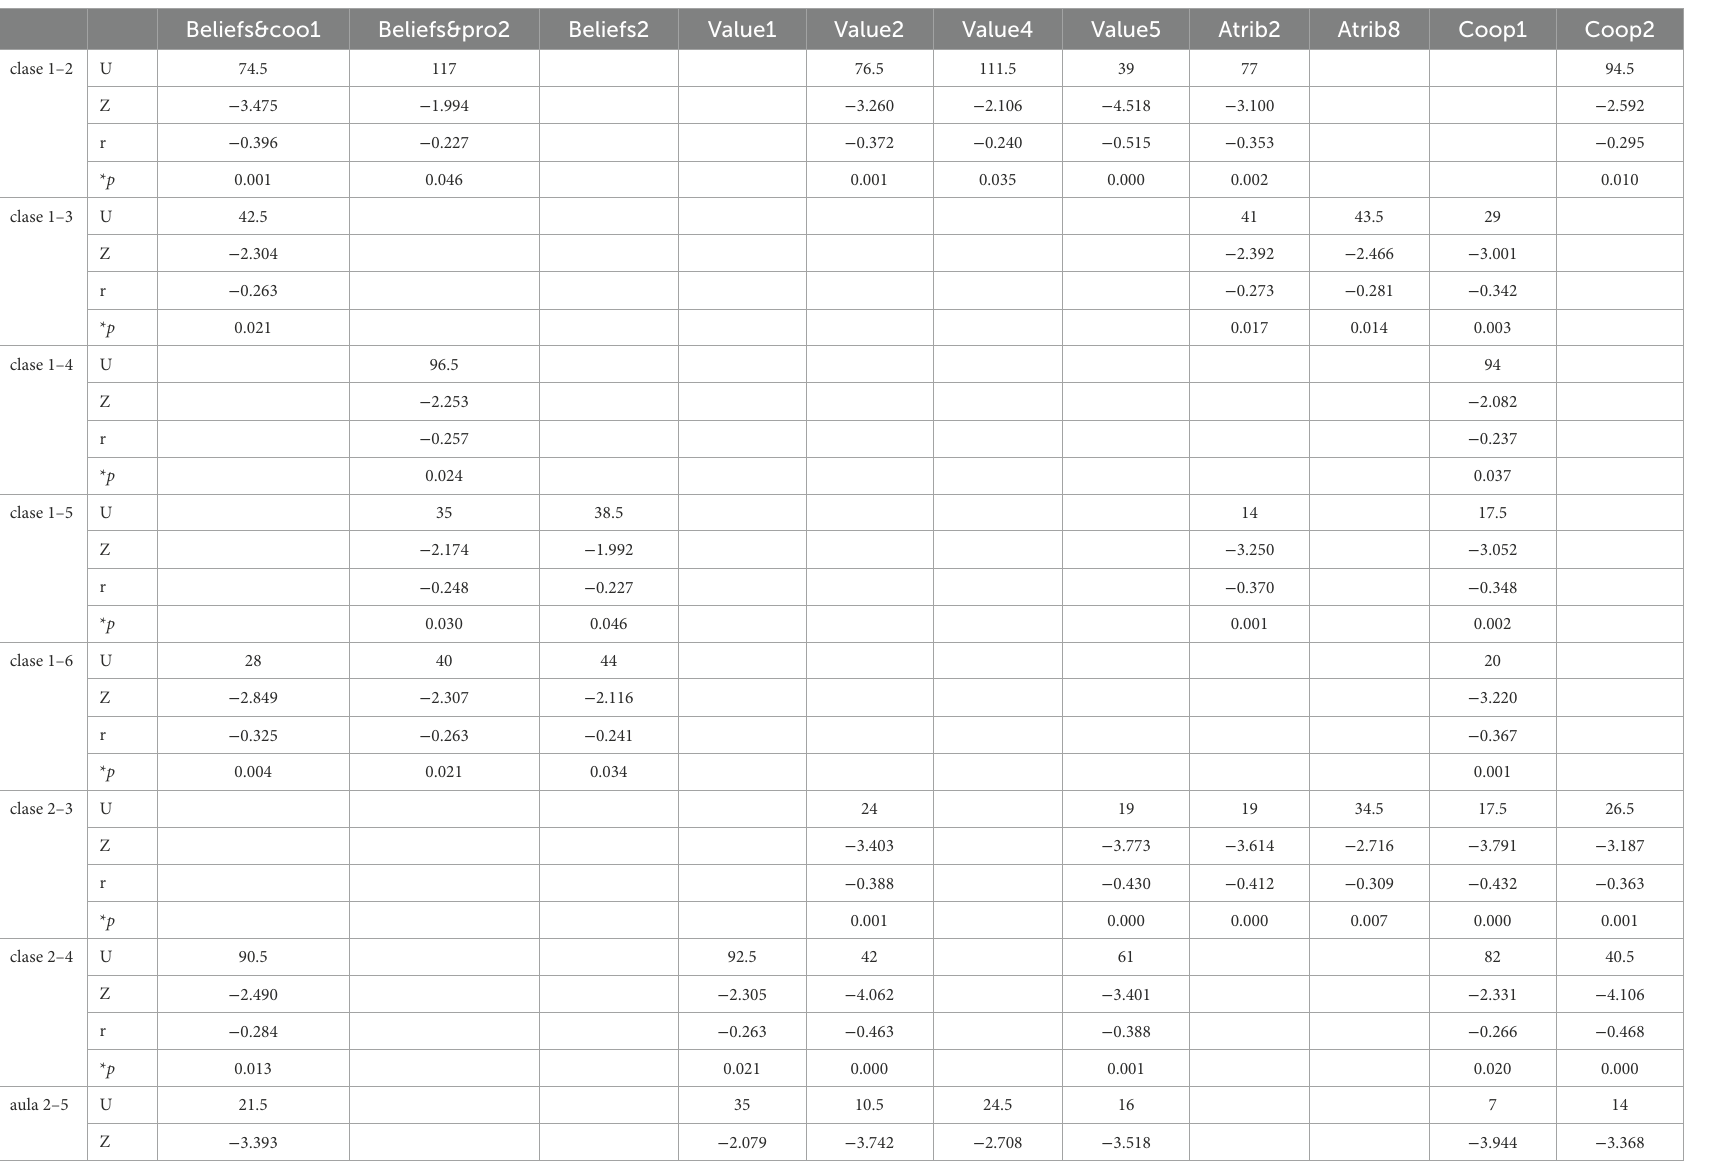
TABLE 8 Post-hoc Mann–Whitney U -Test analysis to evaluate how motivation depends on class ID